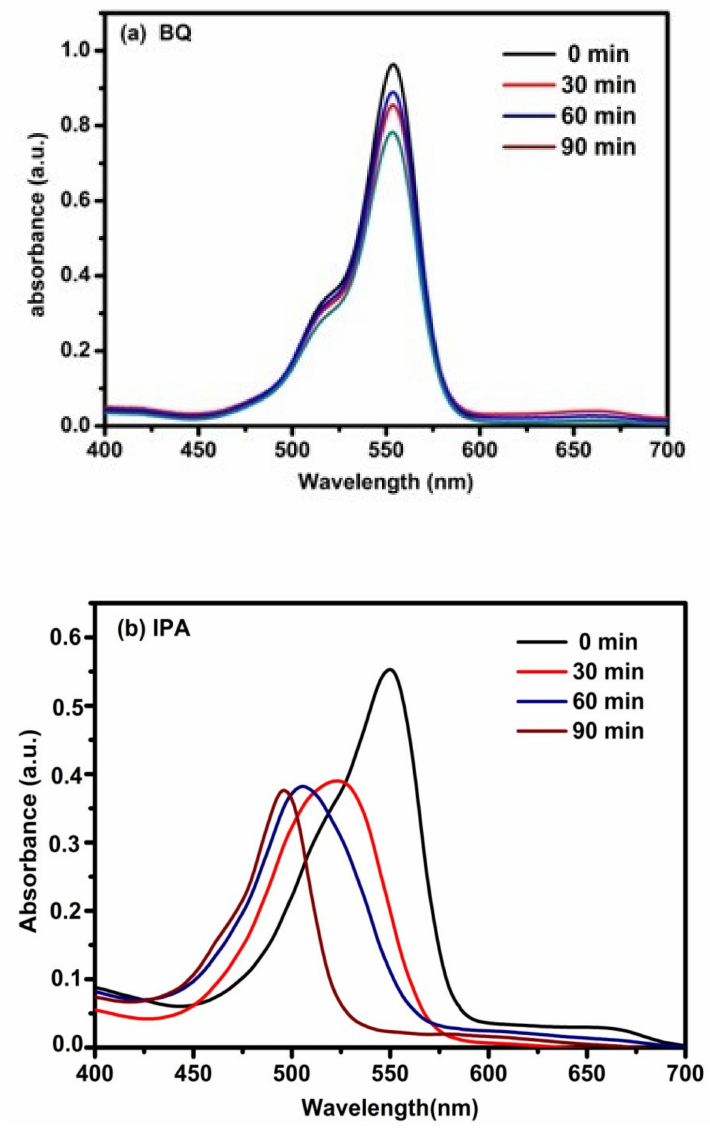
Figure 16. Absorbance spectra of RhB using photocatalyst Ag/Bi 2 WO 6 (1:2) in the presence of scavengers. ( a ) BQ. ( b ) IPA under visible light